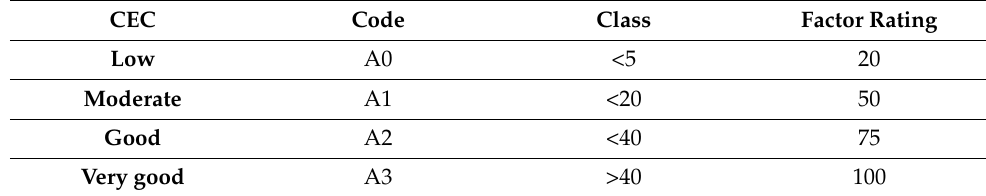
Table 3. Factor ratings of Cation Exchange Capacity (cmol · kg − 1 ).